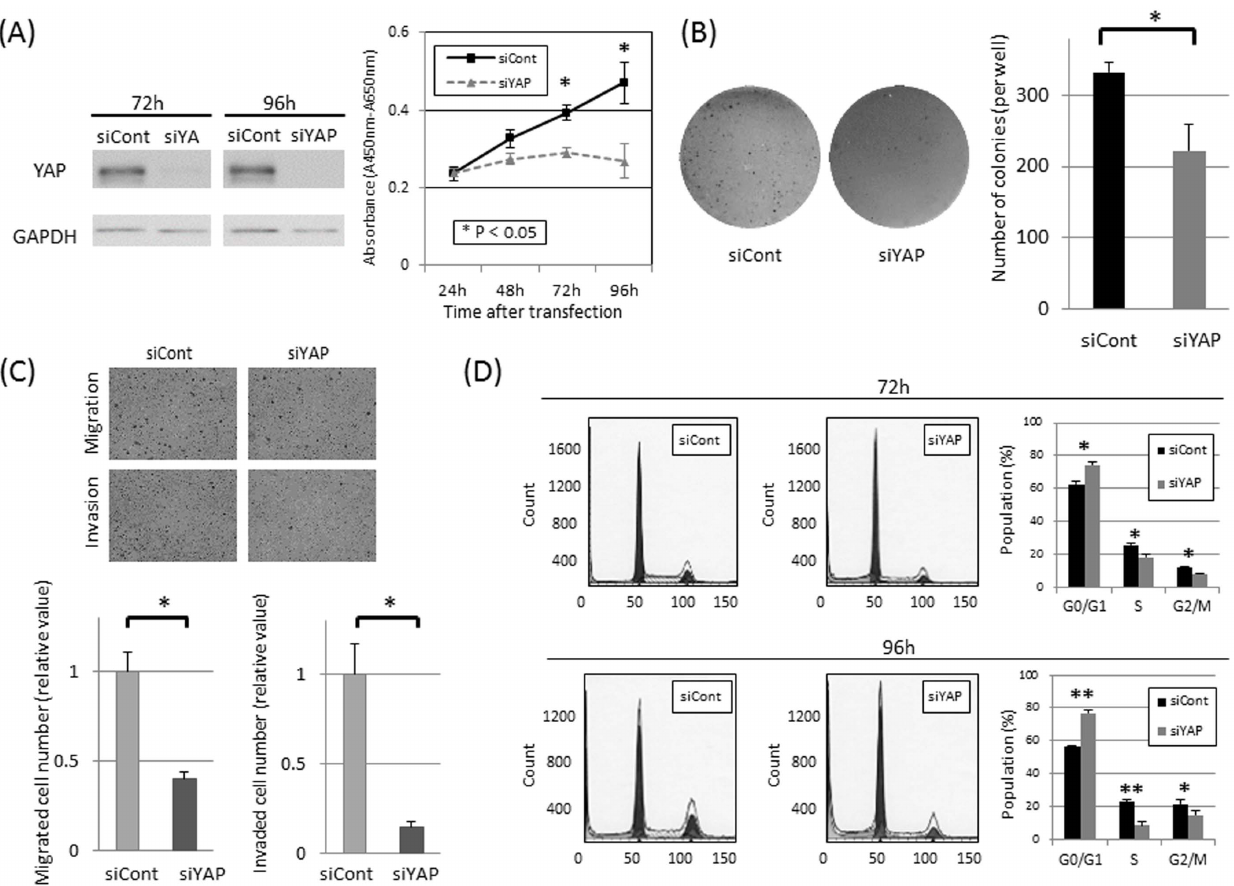
Figure 3. (A) Inhibited protein expression of YAP by YAP-specific siRNA (siYAP) was confirmed by western blotting both 72 and 96 hours after transfection (left). The number of viable cells between 24–96 hours after transfection of siYAP or control siRNA (siCont) was evaluated in HEC-1-B cells using the water-soluble tetrazolium salt assay (Cell counting kit-8) (right). 26.2% and 42.9% inhibition of cell proliferation were confirmed by knockdown of YAP expression at 72 and 96 hours, respectively. (* P , 0.05 (the Mann-Whitney u-test)). Results are shown in means 6 standard deviations (bars) in quadruplicate experiments. Similar trends were obtained in other two independent experiments. (B) The number of colonies in soft agar was compared between the YAP inhibited cells and the control cells to evaluate anchorage-independent cell growth in HEC-1-B cells. Representative image of formed colonies in soft agar (left). Quantitative analysis in number of formed colonies (right), showing a significant decrease in siYAP transfected cells. (* P , 0.05 (the Mann-Whitney u-test)). Columns and bars represent means and standard deviation in sextuplicate experiments. Similar trends were obtained in another independent experiment. (C) Transwell migration and invasion assay. Representative image of migrated/invaded HEC-1-B cells (left). Quantitative analysis in number of migrated/invaded cells (right), which showed a significant decrease in siYAP transfected cells. (* P , 0.05 (the Mann-Whitney u-test)). Columns and bars represent means and standard deviation in quadruplicate experiments. Similar trends were obtained in another independent experiment. (D) Flow cytometric analysis. Representative results of the population in each phase of the cell cycle in HEC-1-B EMCA cells 72 and 96 hours after transfection with siCont/siYAP (left). Quantitative analysis in the population in each phase (right). siYAP transfected cells showed a significant accumulation of cells in G0/G1 phase and significant decreases in S and G2/M phases at 72 and 96 hours (* P , 0.05, ** P , 0.001, the Student’s t- test). Columns and bars represent means and standard deviation in triplicate experiments. Similar trends were obtained in another independent